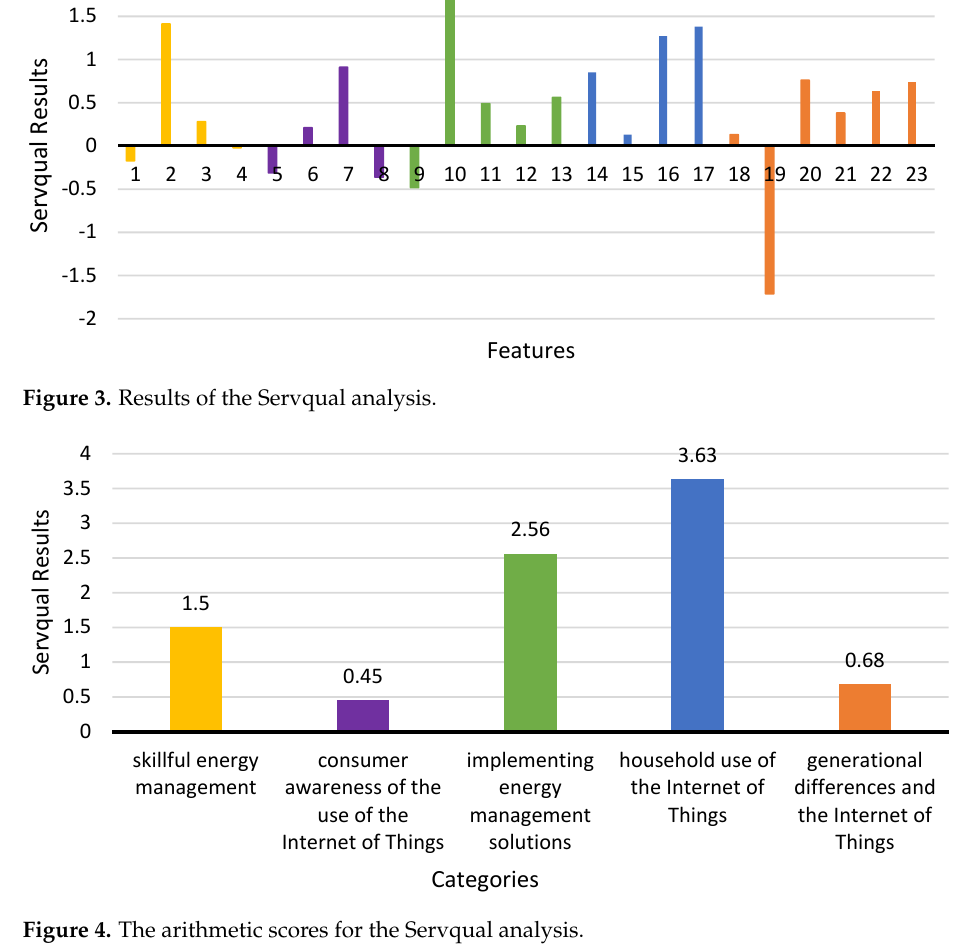
Table 4. Validation assessment of five dimensions for the Servqual analysis.